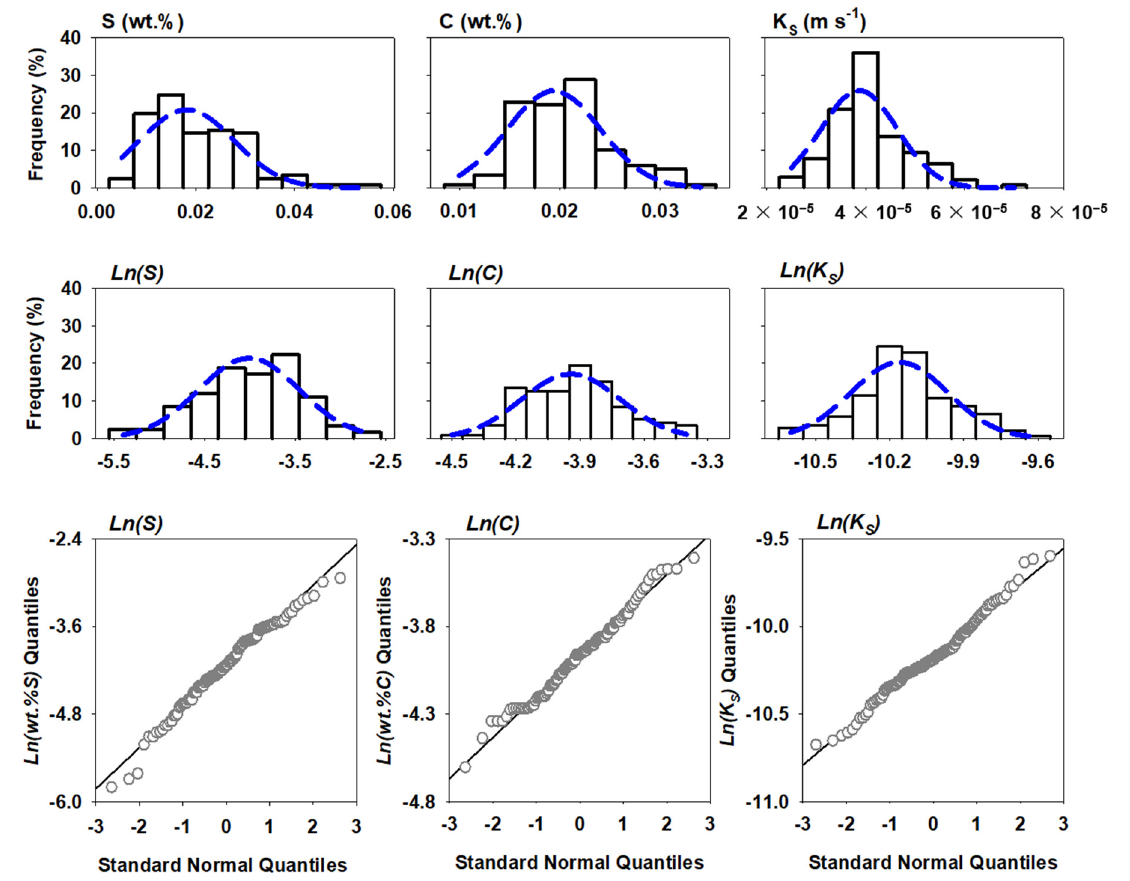
Figure 3. Frequency histograms for Type I deconstruction S (wt.%), C (wt.%), K S (m s − 1 ), Ln(S) , Ln(C) , and Ln(K S ) and quantile–quantile plots for Ln(S) , Ln(C) , and Ln(K S ) . The dashed line on the histograms represents the normal distribution calculated from the population mean and standard deviation; the solid line on the quantile–quantile plots represents the log-normal